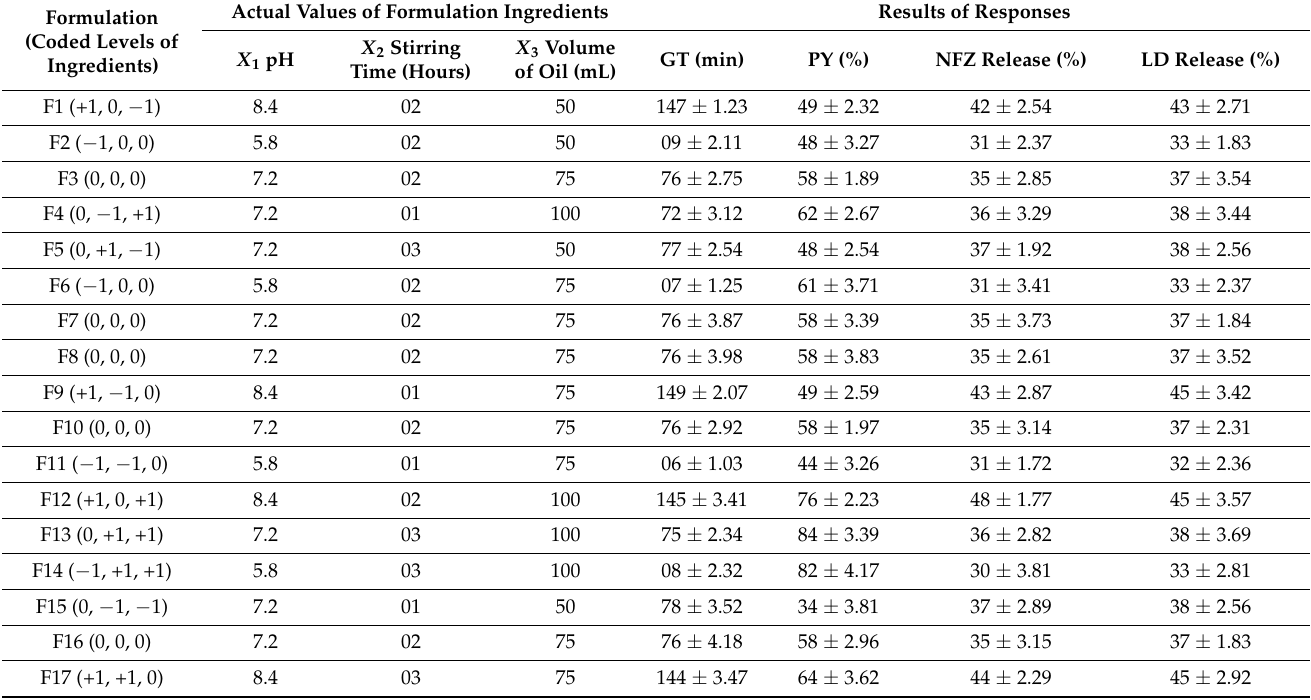
Table 5. Composition of drug-loaded microspheres as designed by the Box–Behnken design and the obtained outcomes of dependent